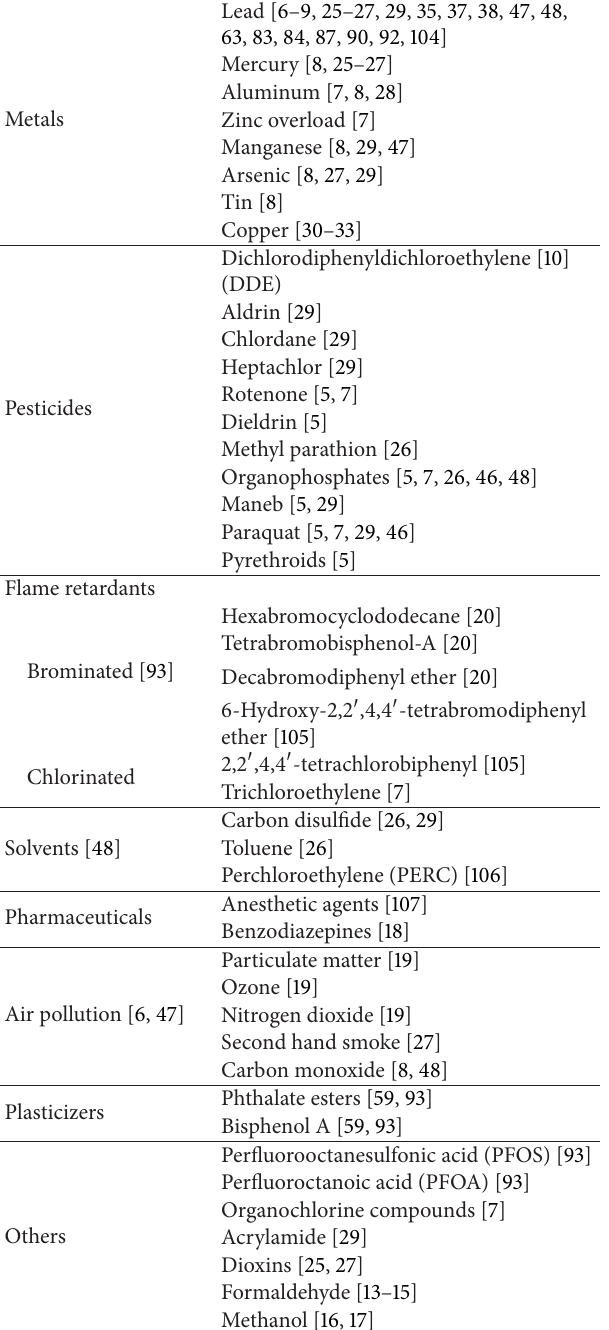
Table 1: Exposures potentially associated with neurodegenerative